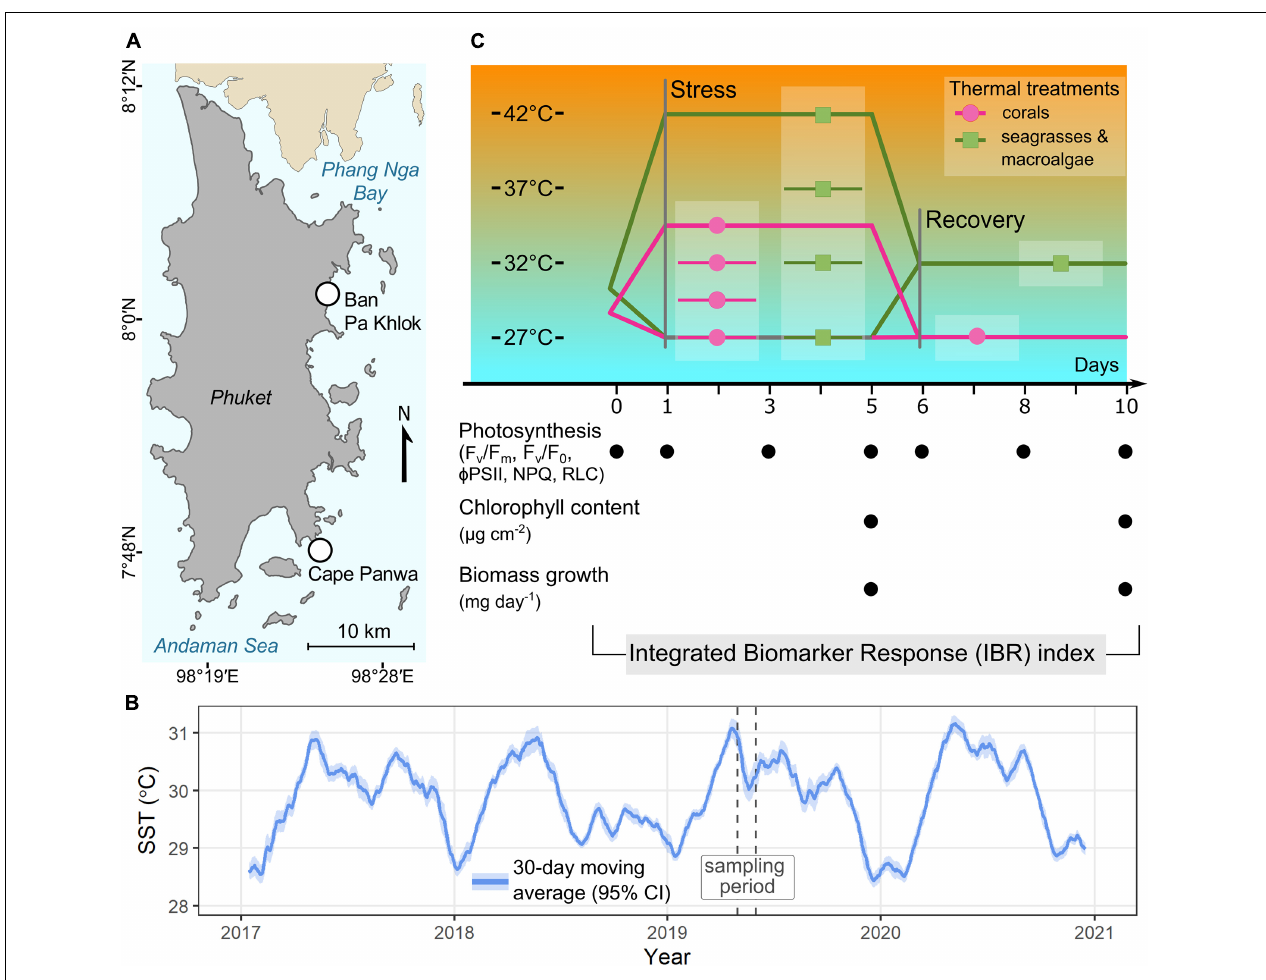
FIGURE 1 | (A) Locations of the sampling sites, (B) average sea surface temperature (SST) in coastal water of Phuket recorded from 2017 to 2020 and (C) experimental design, timeline and investigated parameters. Sea surface temperatures were retrieved from GHRSST Level 4 MUR Global Foundation Sea Surface Temperature Analysis (v4.1) (https://podaac.jpl.nasa.gov/dataset/MUR-JPL-L4-149GLOB-v4.1 accessed on July 01,